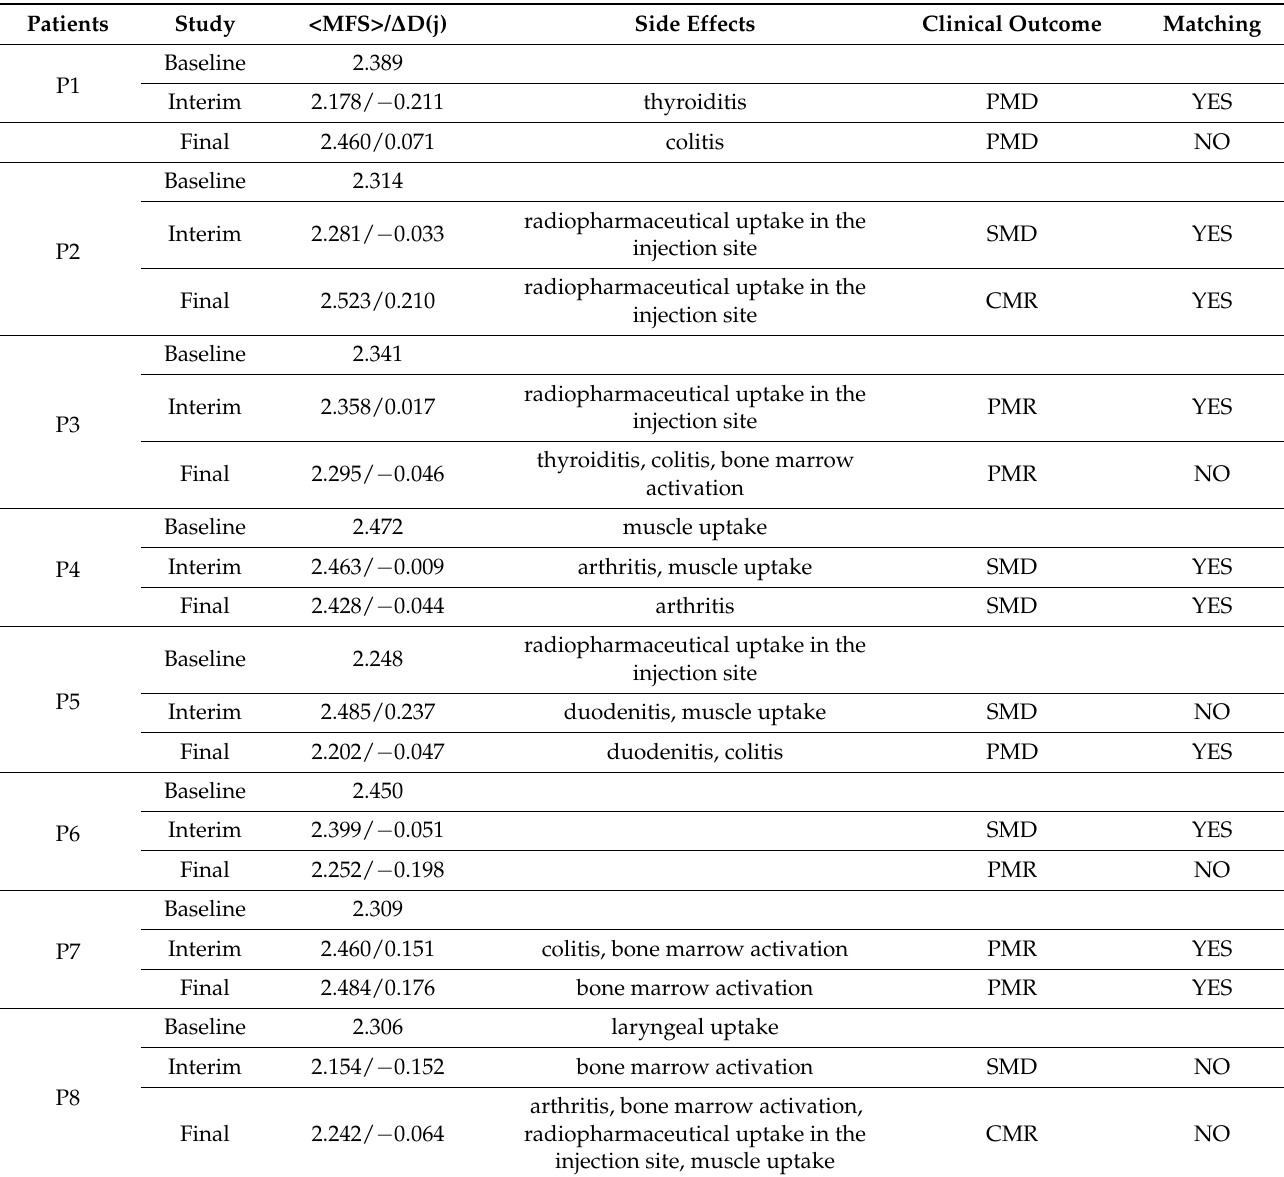
Table 3. Presentation of MFS and cumulative measure ∆ D(j) results, for patients and healthy controls.